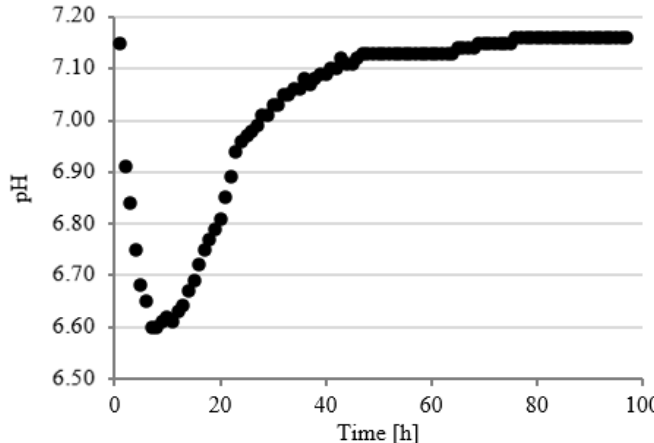
Figure 10. Course of pH changes in series 3.